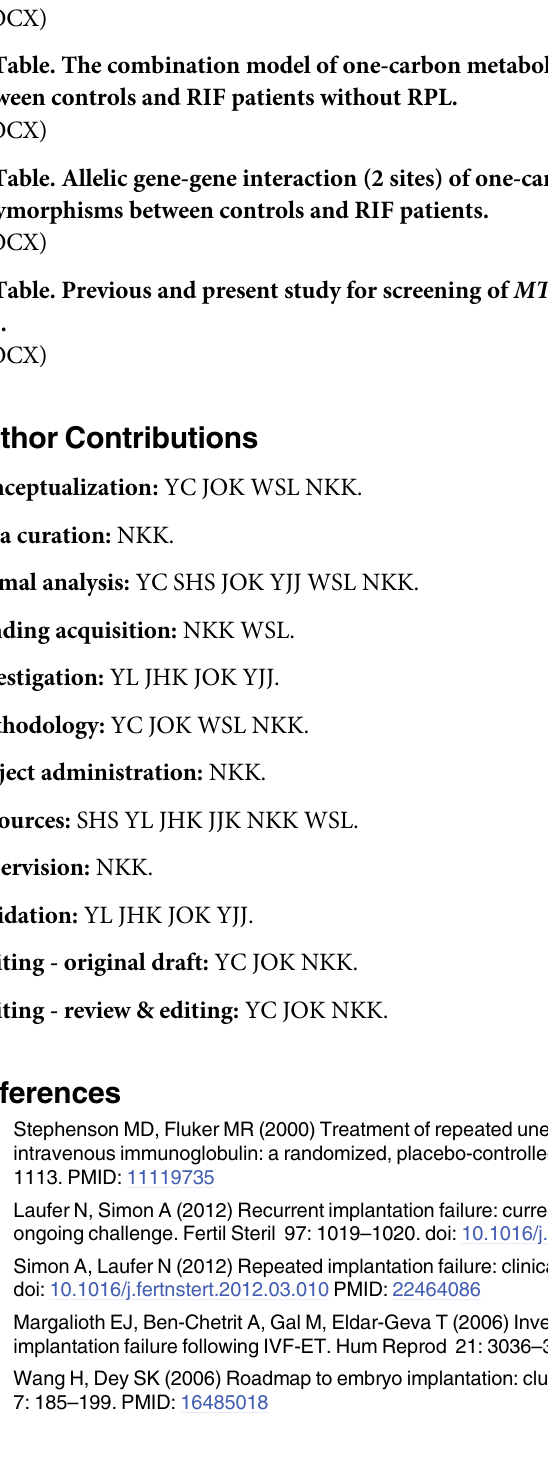
S2 Table. Genotype frequencies of one-carbon metabolism-related gene polymorphisms between controls and RIF patients according to IF numbers. S3 Table. The combination model of one-carbon metabolism-related gene polymorphisms between controls and RIF patients according to IF numbers. S4 Table. The combination model of one-carbon metabolism-related gene polymorphisms between controls and RIF patients without RPL. S5 Table. Allelic gene-gene interaction (2 sites) of one-carbon metabolism-related gene polymorphisms between controls and RIF patients. S6 Table. Previous and present study for screening of MTHFR 677C > T polymorphisms in